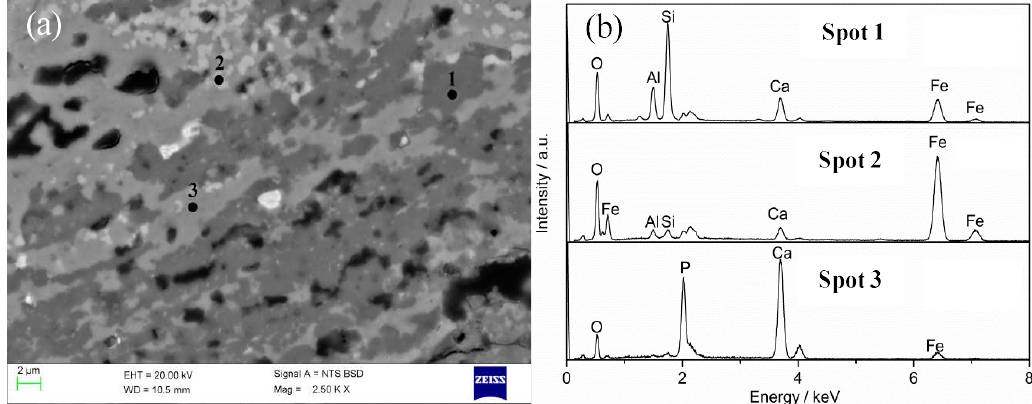
Figure 16. SEM image of slag phase and EDS analyses (reduction time of 20 min): ( a ) SEM image and ( b ) EDS analyses.